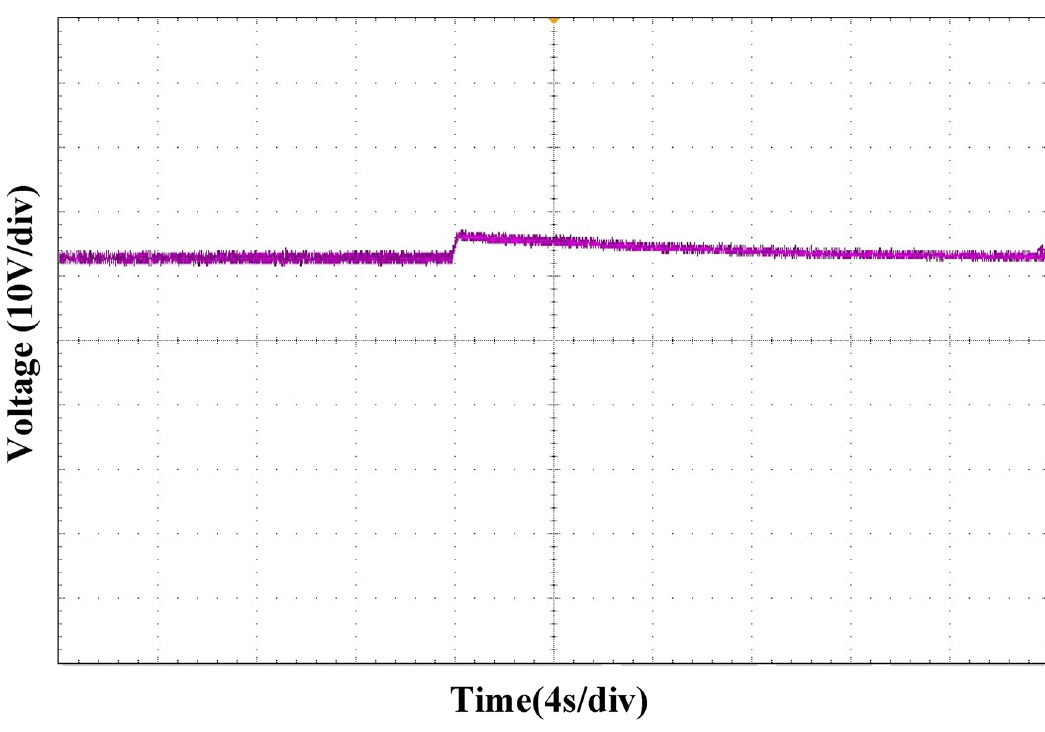
Fig 27. Load switching waveform under PI control strategy.